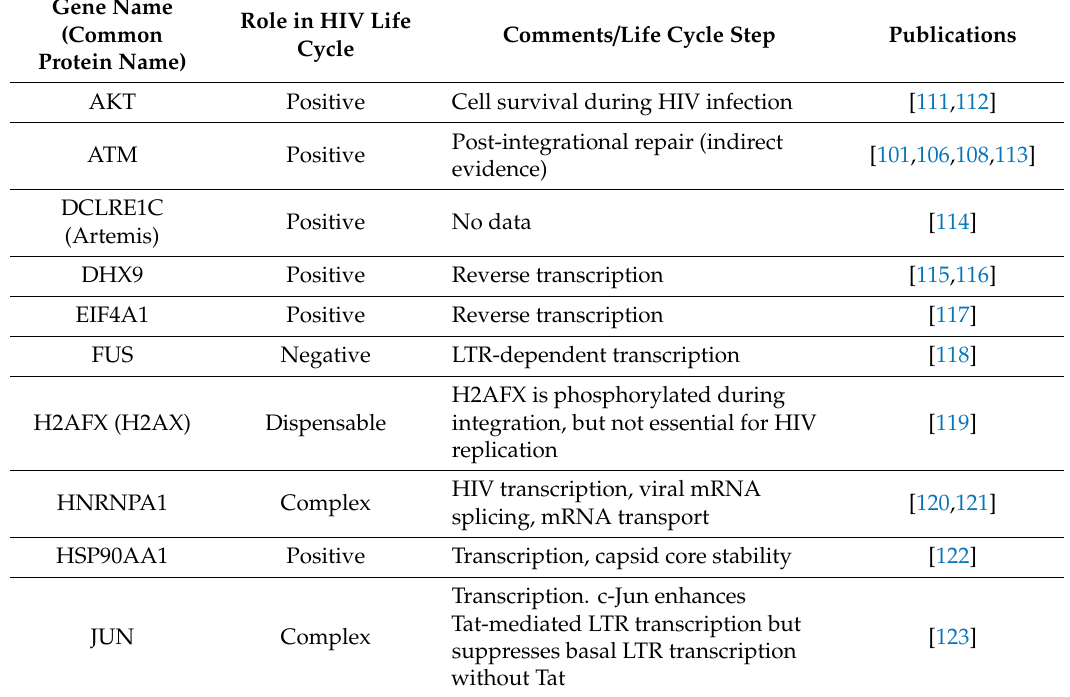
Table 2. E ff ects of DNA-PKcs targets on HIV-1